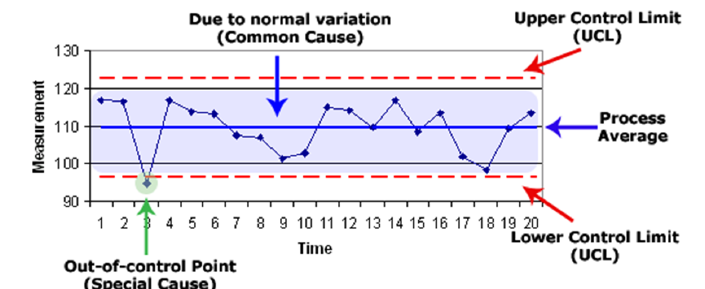
Fig. 3. Components of Statistical Control